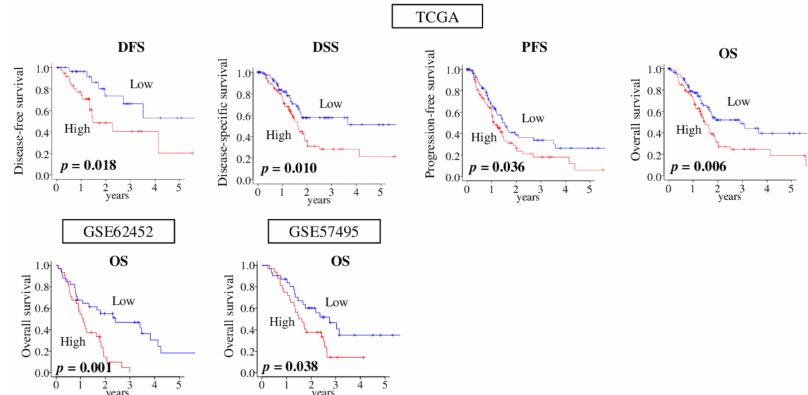
Figure 5. Association of G2M pathway score and pancreatic cancer patient survival in TCGA, GSE62452, and GSE57495 cohorts. Kaplan–Meier survival plots comparing low and high G2M score tumors for disease-free survival ( DFS ), disease-specific survival ( DSS ), progression-free survival ( PFS ), and overall survival ( OS ) in the TCGA ( n = 176) cohort, and OS in GSE62452 ( n = 69), and GSE57495 ( n = 63) cohorts. High and low score groups were divided by the median value. Log rank test was used to compare between two groups with Kaplan–Meier survival curves and to calculate p- values.